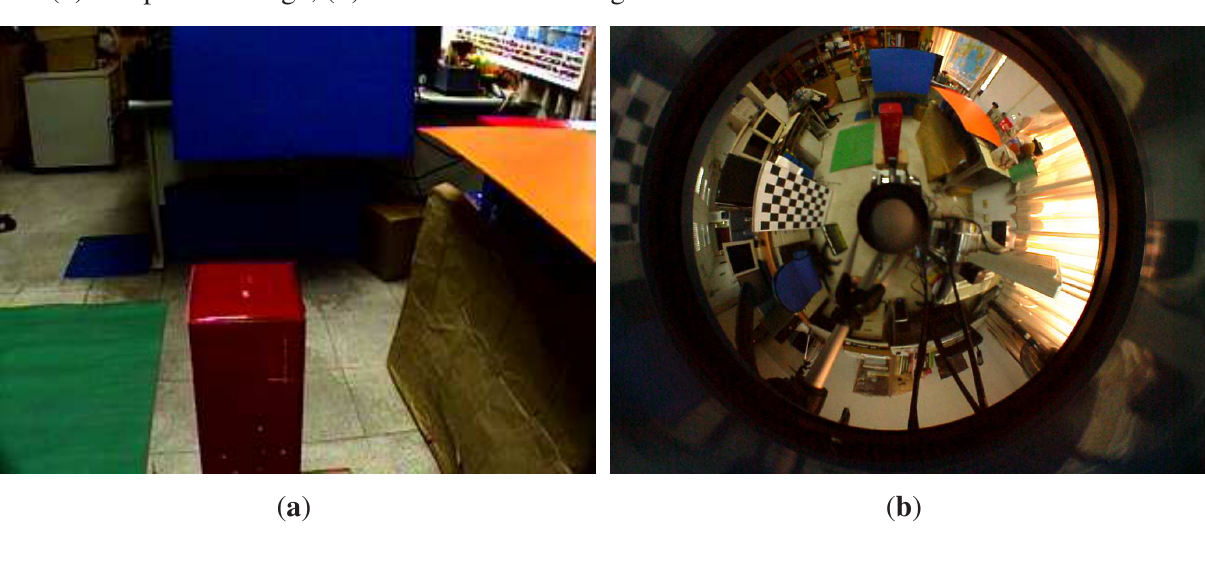
Figure 8. The hybrid omnidirectional and perspective image pair used for the first experiment. The image resolutions are 320 × 240 and 1024 × 768 , respectively.